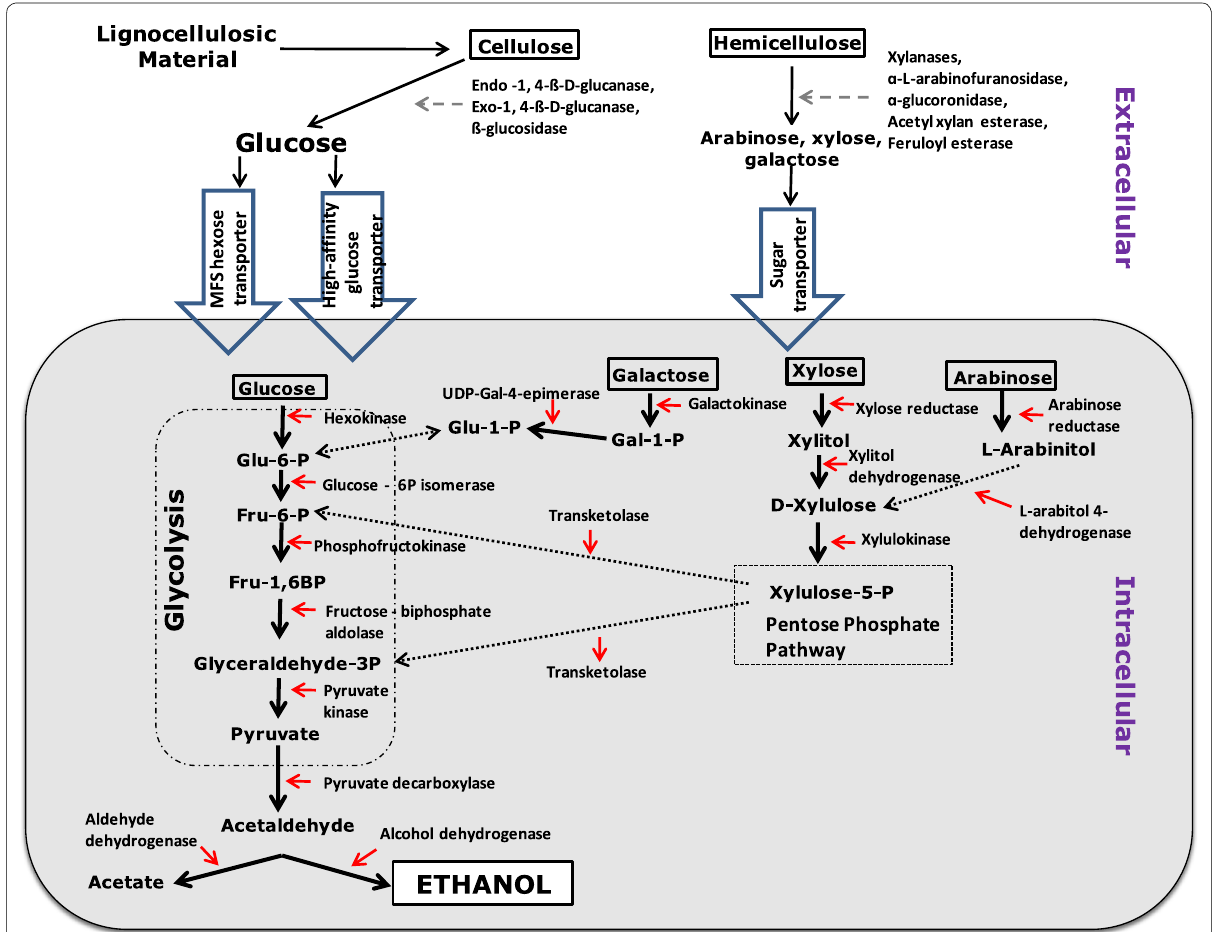
Fig. 2 The metabolic pathway involved in the bioconversion of lignocellulosic material to bioethanol by Fusarium oxysporum . Glu-6-P Glucose- 6-Phosphate, Fru-6-P Fructose-6-Phosphate, Fru-1, 6BP fructose-1, 6-biphosphate, glyceraldehyde-3P glyceraldehyde-3-phosphate, Glu-1-P glucose- 1-phosphate, Gal-1-P galactose-1-phosphate, Xylulose-5-P